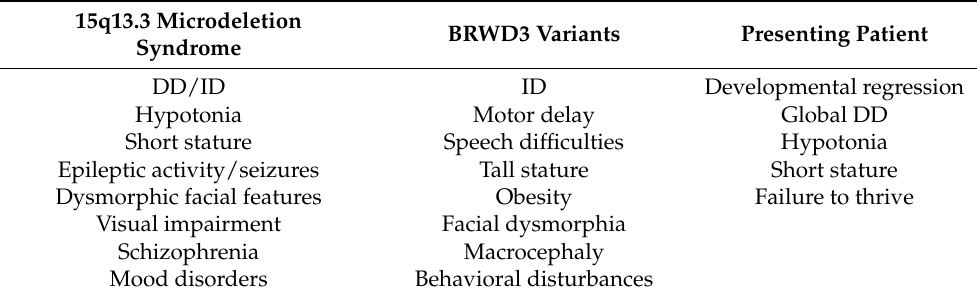
Table 1. Summary of common clinical features in 15q13.3 microdeletion syndrome and BRWD3 variants compared to the presenting